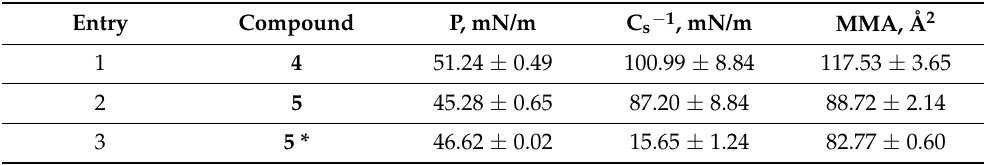
Table 2. Mechanical properties of monolayers composed of 1,4-DHP amphiphiles 4 and 5 obtained using the Langmuir–Blodgett trough. P (mN/m) is the critical pressure of the monolayers; C s − 1 (mN/m) is the compressibility modulus; MMA (Å 2 ) is the mean molecular area.